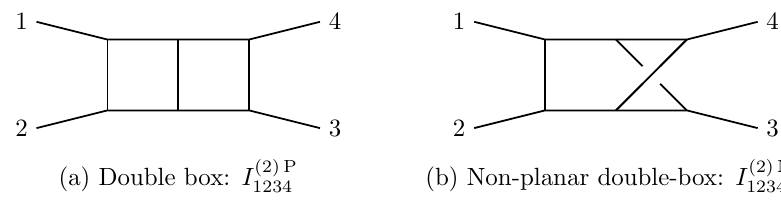
Figure 3. Massless two-loop